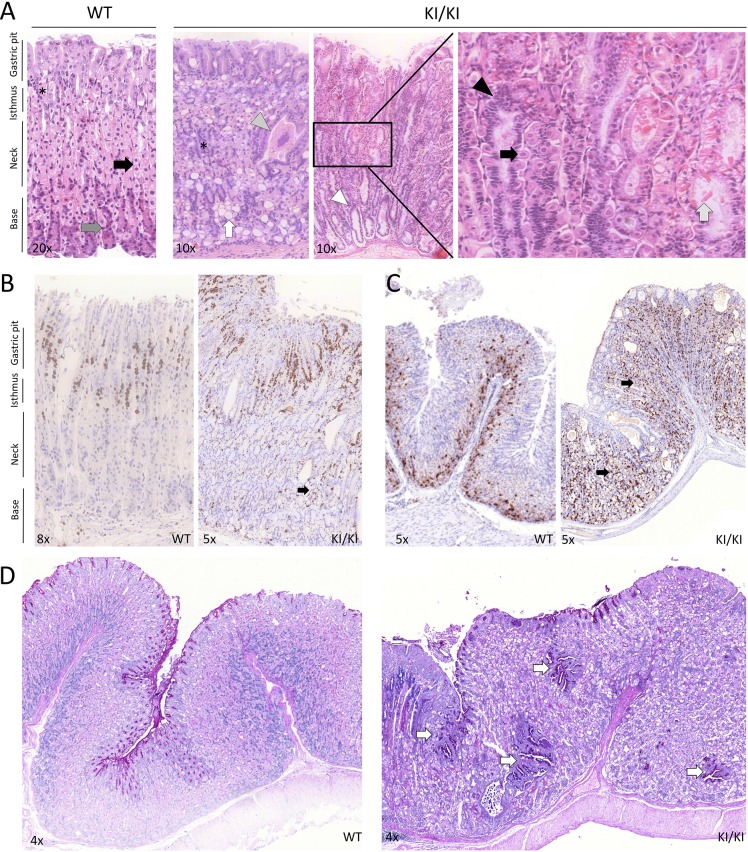
Histological alterations in the corpus region of the stomach. (A) Representative H&E staining of a transverse section of stomach from mice at one year of age. In WT mice, progenitor cells are located in the isthmus (asterisk), PCs (basic staining) stain magenta with H&E and are located in the neck (black arrow). ECL cells and zymogenic cells (acid staining) stain dark purple with H&E and are located at the base of oxyntic glands (gray arrow). In KI/KI mice, cellular disorganization and increased thickness of the stomach wall were observed, characterized by the presence of proliferating cells (at isthmus in WT mice) and ECL-cells (at base in WT mice) within the neck region of gastric corpus glands (asterisk). In addition, high numbers of epidermoid cysts surrounded by a single layer of cuboidal epithelium (gray arrowhead), vacuolization of gastric mucosal cells (white arrow) and widely opened lumen of the oxyntic glands (white arrowhead) were seen in KI/KI mice. In the enlarged image at the far right, increased number of grouped cells from the isthmus region (black arrowhead), dysplastic cytoplasms of PCs (black arrow) and hyalinosis (light gray arrow), indicating a premalignant condition, are shown. (B) IHC of gastric corpus stained with anti-Ki67 antibody. In WT mice, the staining is limited to the isthmus region, which is the proliferative zone. Increased Ki67 staining is observed in the KI/KI stomach isthmus, but is also seen in the neck region (black arrow). (C) IHC of gastric corpus stained with anti-chromogranin A antibody. In WT mice, the staining is limited to the base of the oxyntic glands whereas in KI/KI stomachs it is also seen in the entire neck region (black arrows). (D) Alcian Blue-PAS staining of the corpus region of the stomach of WT (left) and KI/KI (right) mice. White arrows show areas of glandular metaplasia in the KI/KI stomach.